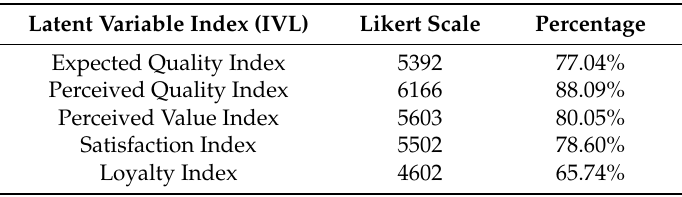
Table 5. The indices of the latent variables